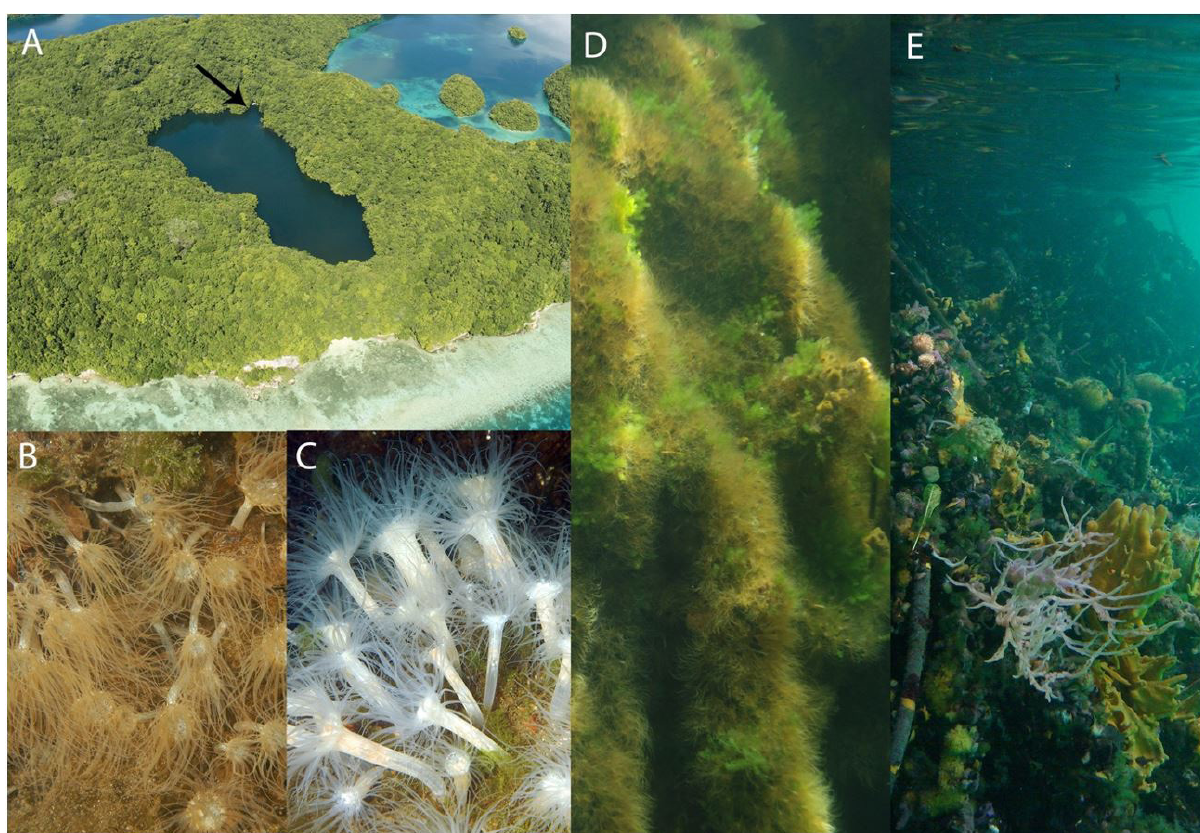
Figure 2. (A) An aerial photograph of Jellyfish Lake, showing its physical isolation from the ocean (photo courtesy of Mandy Etpison). Black arrow points to side-arm of lake, where the entry dock is located and where the first introduction of the sea anemone, Exaiptasia pallida , was discovered and documented, see Figure 3. (B) The introduced Exaiptaisa pallida contrasted with (C) the endemic sea anemone, Entacmaea medusivora , in Jellyfish Lake. (D-E) Photographs of mangrove roots with and without E . pallida in Jellyfish